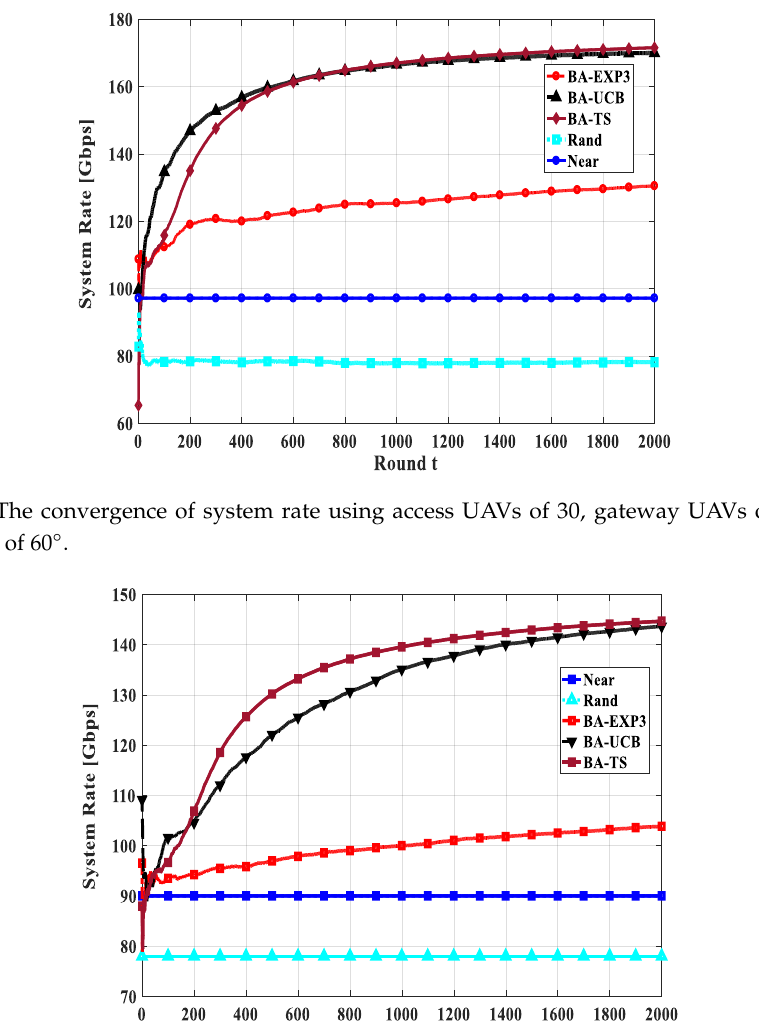
Figure 10. The convergence of system rate using access UAVs of 20, gateway UAVs of 20, and a beam-width of 60°.